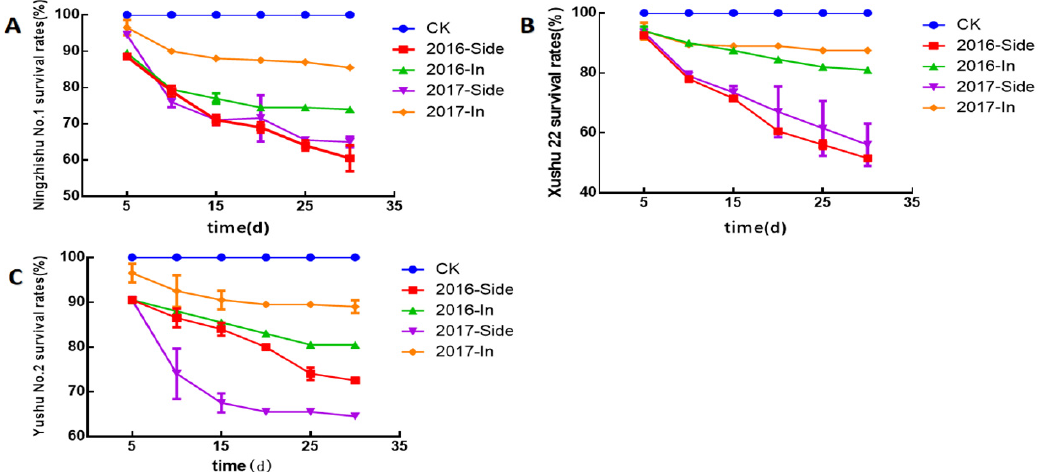
Figure 1. The survival rate of three sweet potato varieties, Ningzhishu No.1 ( A ), Xushu 22 ( B ) and Yushu No.2 ( C ), tested by insertion and side grafting method in years 2016 and 2017. Error bars indicate the standard deviation from two independent replicates.